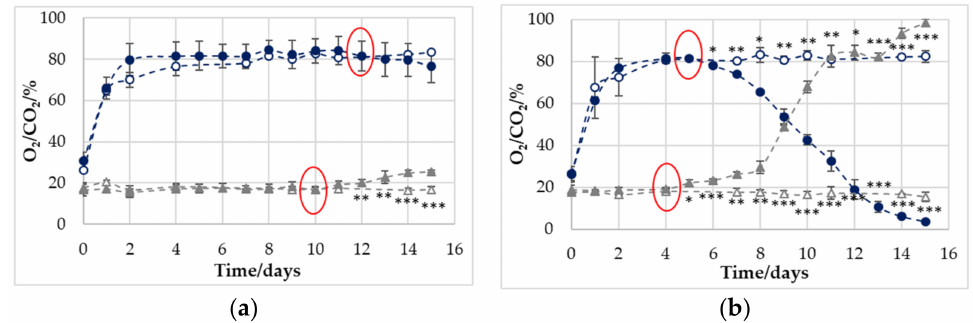
Figure 1. Development of O 2 ( / • ) and CO 2 ( (cid:52) / (cid:78) ) under different storage conditions over fifteen (cid:35) days in trays with ( • / (cid:78) ) and without poultry ( / (cid:52) ): ( a ) 80% O 2 /20% CO 2 4 ◦ C ( b ) 80% O 2 /20% (cid:35) CO 2 10 ◦ C. Indices indicate a significant difference between the curves with and without poultry. * p < 0.05, ** p < 0.01, and *** p < 0.001. The red circles mark the point when the curve of the respective gas concentration in the filled trays intersects that for the empty trays (cross-over), which indicated a microbiologically-induced change in the headspace